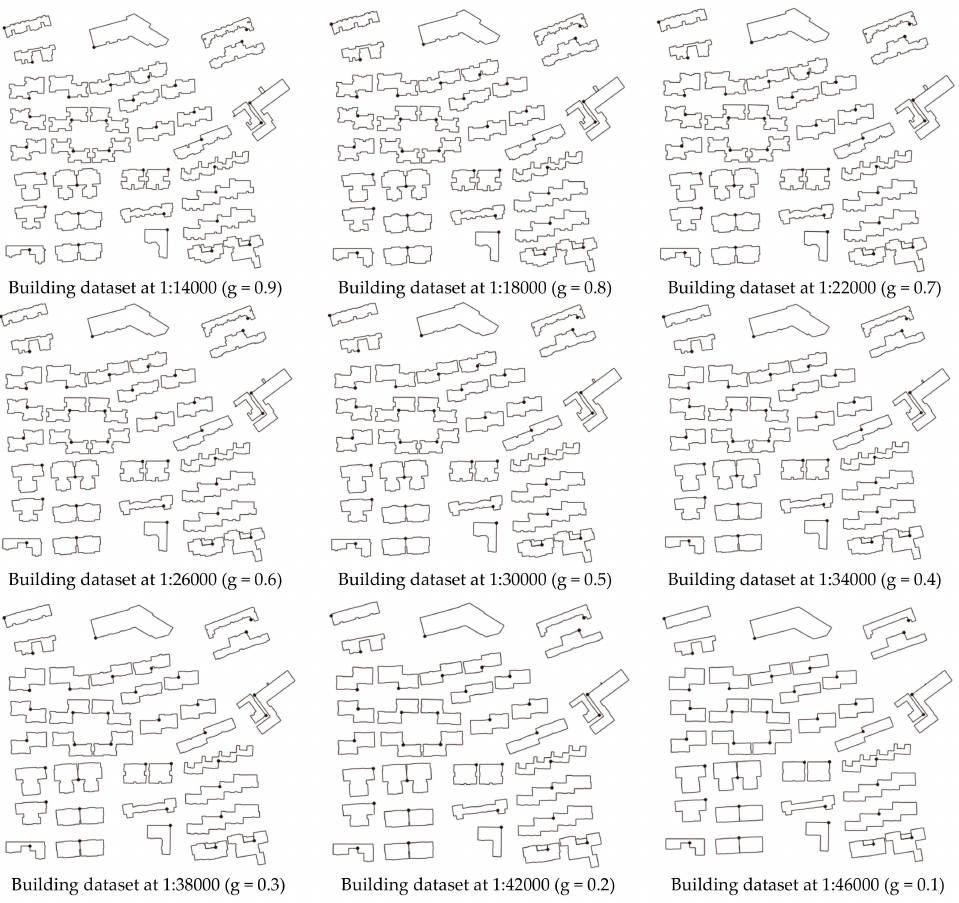
Figure 9. Continuous generalization of a building map using